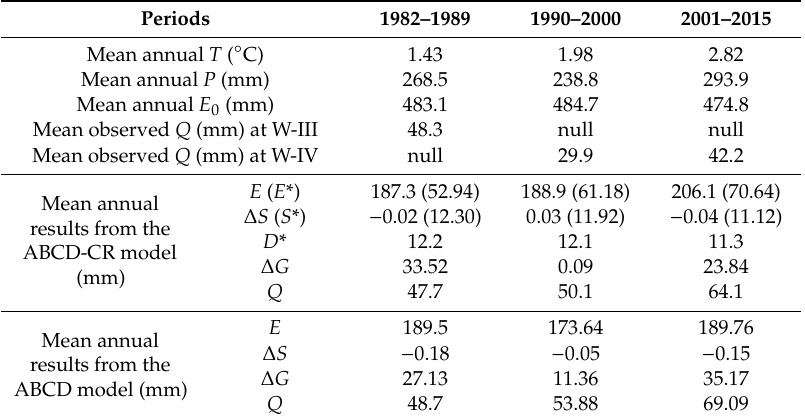
Table 4. Water balance data in different periods.